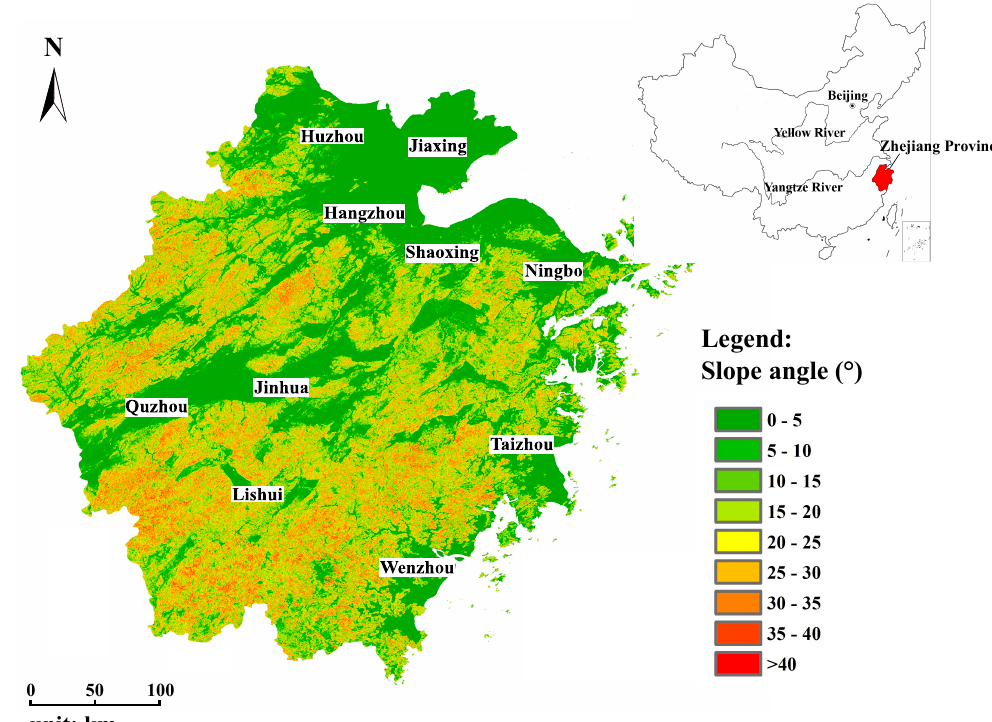
Figure 1. Topographic map of Zhejiang Province generated from 500 × 500 m digital elevation model.